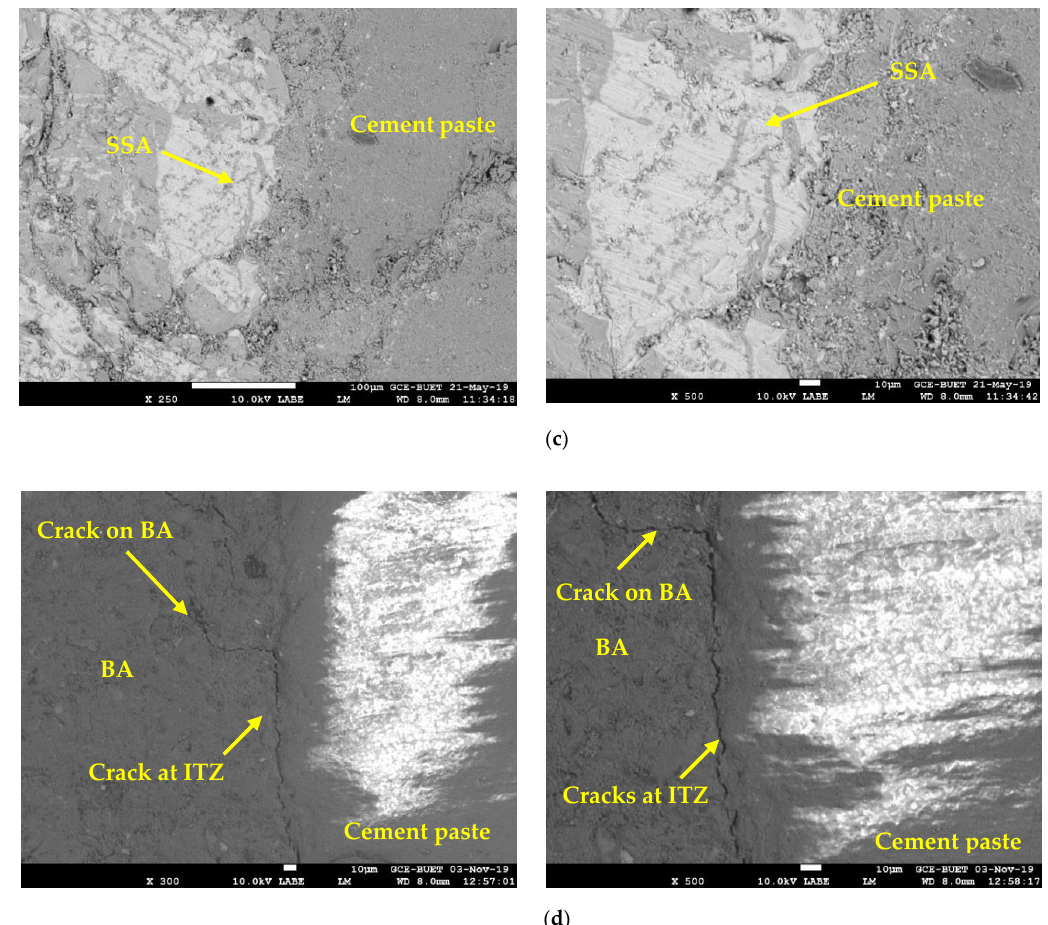
Figure 11. SEM images of SSA ( a ), BA ( b ), interfacial transition zone (ITZ) of concrete made with SSA ( c ) and ITZ of concrete made with BA ( d ), respectively.